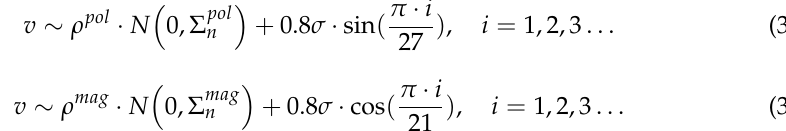
noise covariance is an unknown time-varying random